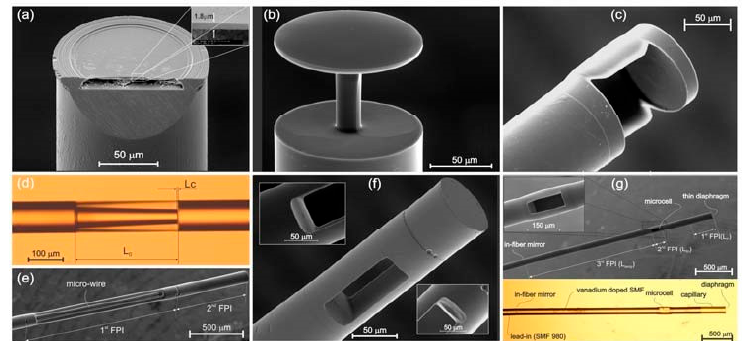
Figure 1. Micromachined sensor devices: ( a ) Pressure sensor (side polished to expose diaphragm), ( b ) Micro-resonator ( c ) Microcell on the fiber tip, ( d ) Strain sensor, ( e ) Relative humidity sensor, ( f ) Refractive index and pressure sensor, and ( g ) Four parameter sensor for sensing of: thermal conductivity, pressure, refractive index and